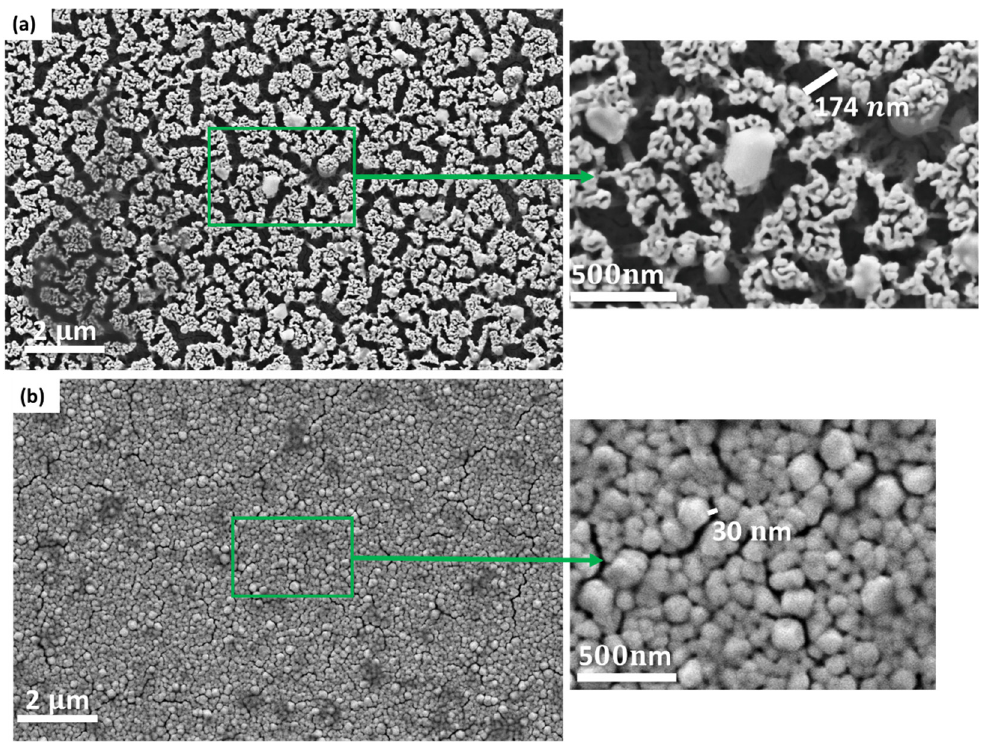
Figure 5. SEM images of the gold substrates: ( a ) porous gold substrate shows larger pore sizes 174 nm; ( b ) nonporous gold substrates with small pore sizes 30 nm. 174 nm; ( b ) nonporous gold substrates with small pore sizes 30